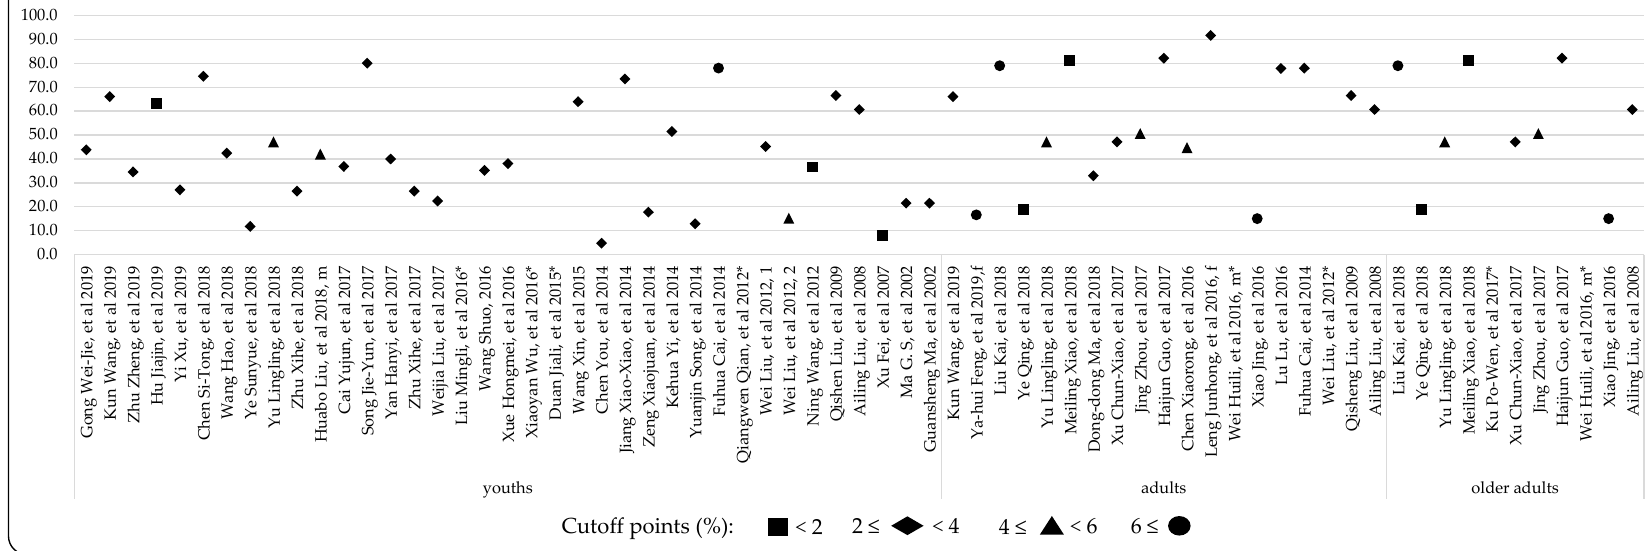
Figure 5. The prevalence (%) of SB of included studies reporting the cutoff points (in the form [198]) (abbreviations: * No information on overall prevalence available; m = male; f = female; youths < 18 years; 18 years ≤ adults < 65 years; older adult ≥ 65 years; Wei Liu, et al. 2012, 1 = screen time [177]; Wei Liu, et al. 2012, 2 = sitting time [177]).